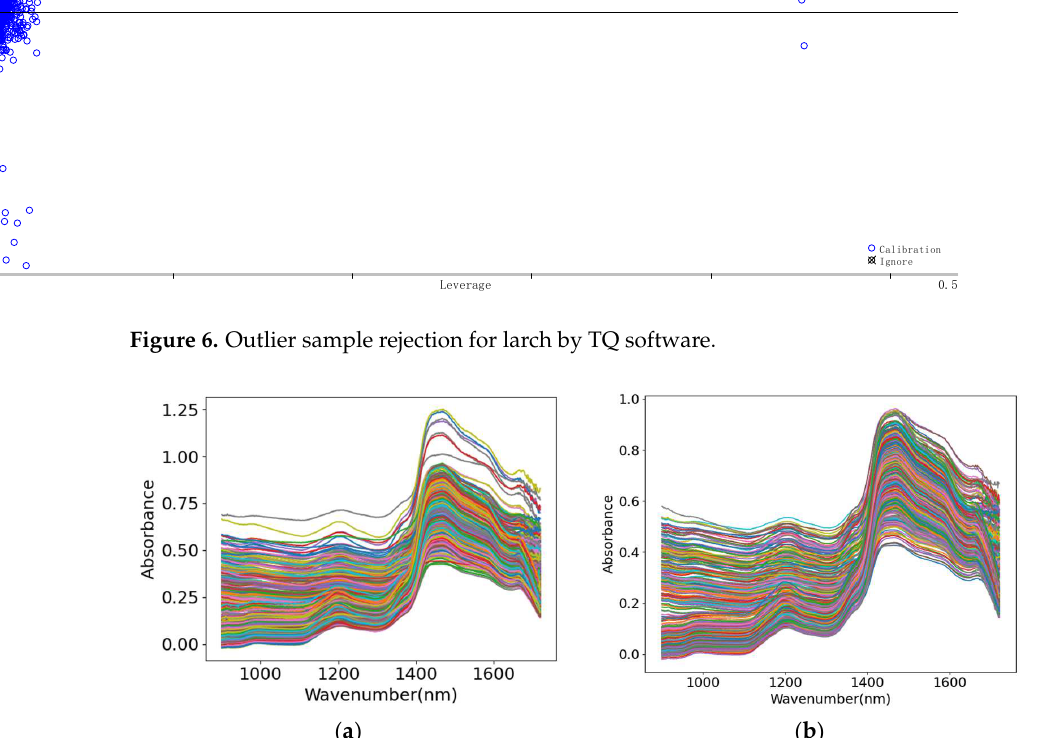
Figure 8. Distribution of reference values of three coniferous wood samples after the rejection of outlier sample. 4.1.2. Spectral Preprocessing Results After rejecting the outlier samples, the spectra are subjected to preprocessing opera- tions. In general, the processing sequence begins with a derivative for baseline correction, followed by smoothing and denoising, and then scattering correction and normalization. This study establishes a full-wavelength PLSR model, where n components = 3 for PLSR. The commonly used sample selection methods include random selection, Kennard–Stone (K-S), and Sample set Partitioning Based on Joint X-Y Distances (SPXY). The SPXY is gen- erally superior to K-S and random selection [31]. Therefore, the SPXY sample selection method is chosen to divide the training set and test set by 4:1. The remaining one is used